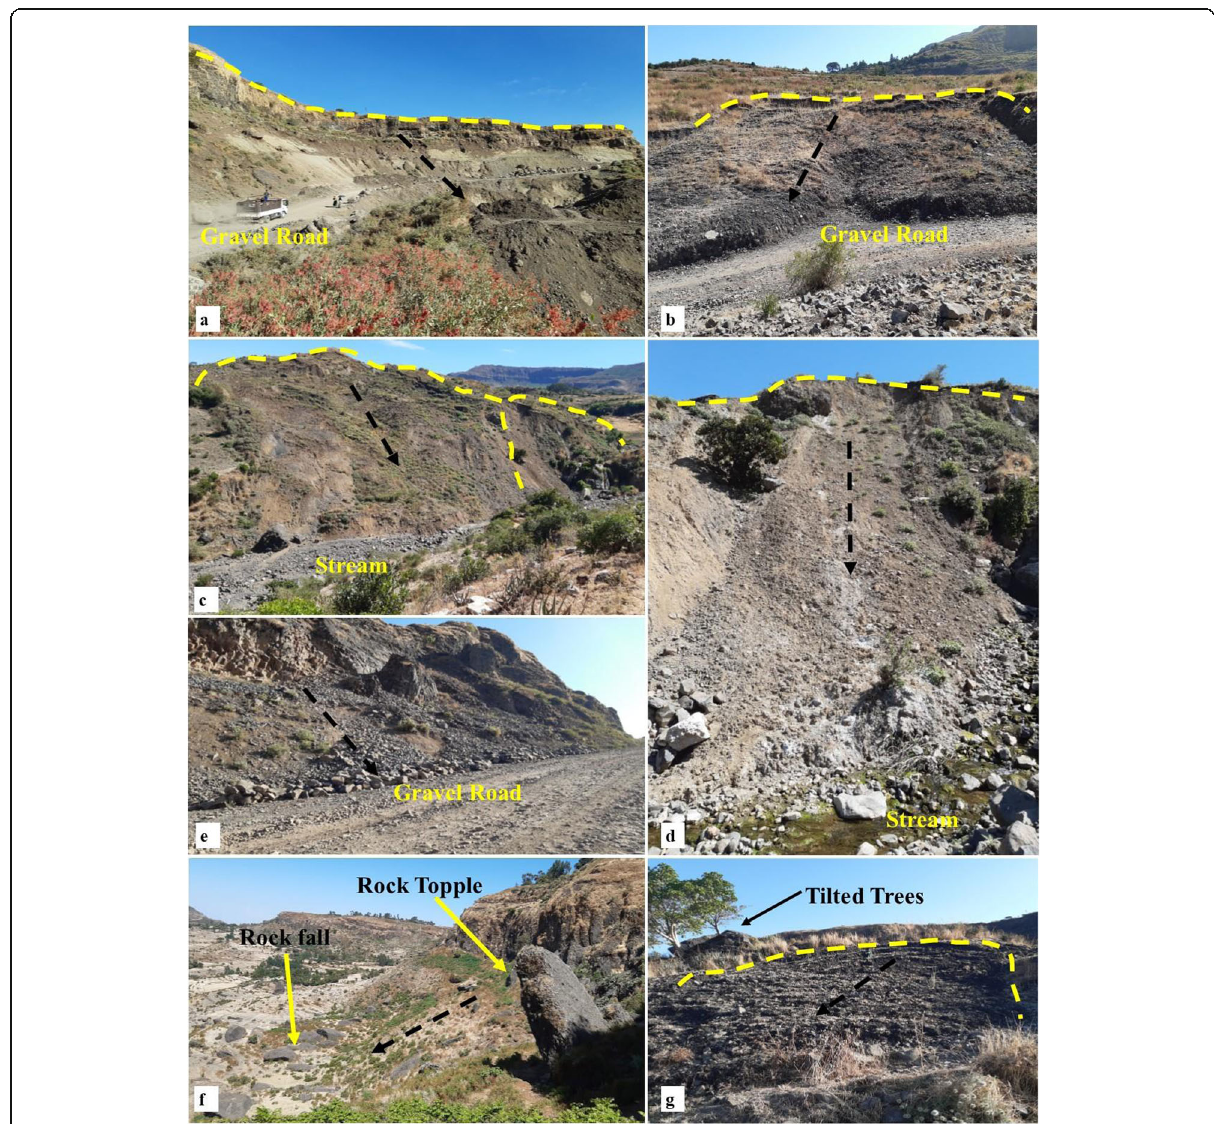
Fig. 5 Field photos illustrating different landslide types. Yellow dotted lines indicate the main scarp of a landslide and black dotted line indicates direction of the slide. a Debris slide ( b ) Lateral spread ( c ) Earth slide ( d ) Debris flow ( e ) Rock slide ( f ) Rockfall and Topple and ( g )